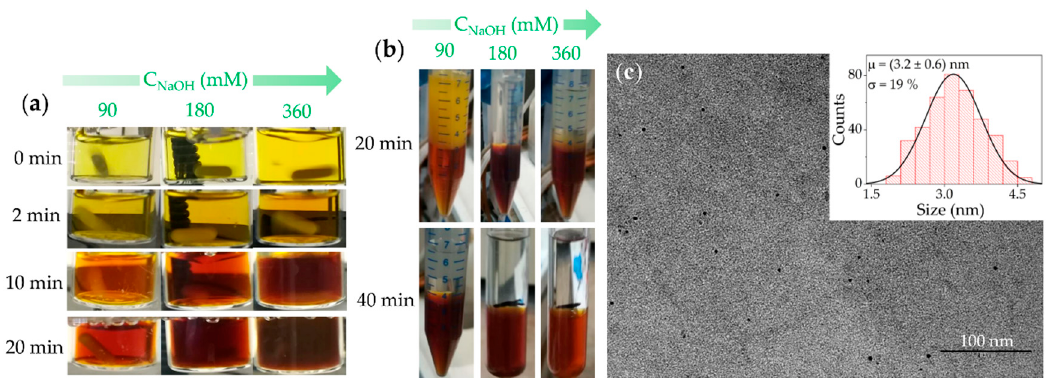
Figure 3. ( a ) Pictures of the vials containing the CPC initial solutions after the addition of 90, 180 and 360 mM NaOH solutions at 70 °C, at different reaction times; ( b ) Pictures of vials containing TPS after the separation procedure performed on the samples in ( a ) at reaction times of 20 and 40 min; ( c ) TEM micrograph (scale bar 100 nm) and size distribution analysis of the resulting CDs.